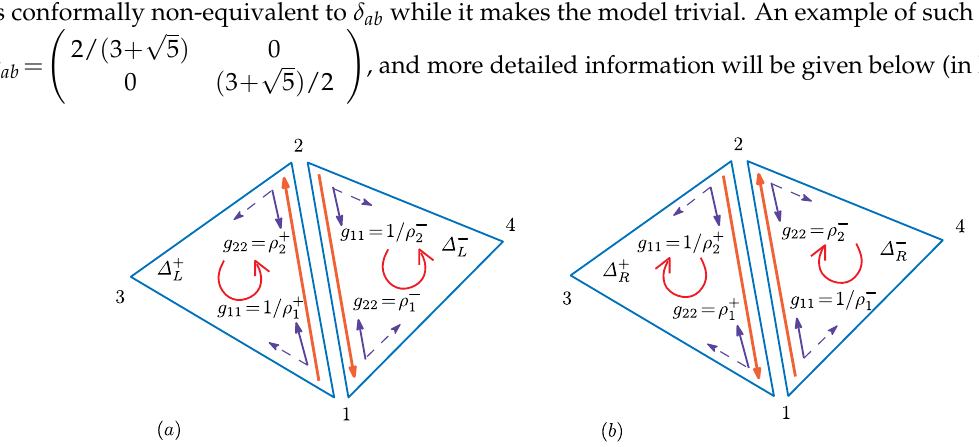
Figure 3. ( a ) Two neighboring triangles ∆ ± and elements of g ab for the direction dependent length of bond 12 at the vertices 1 and 2; and ( b ) the inverted triangles ∆ ± dependent lengths of bond 12 are indicated by long arrows in both ∆ ±